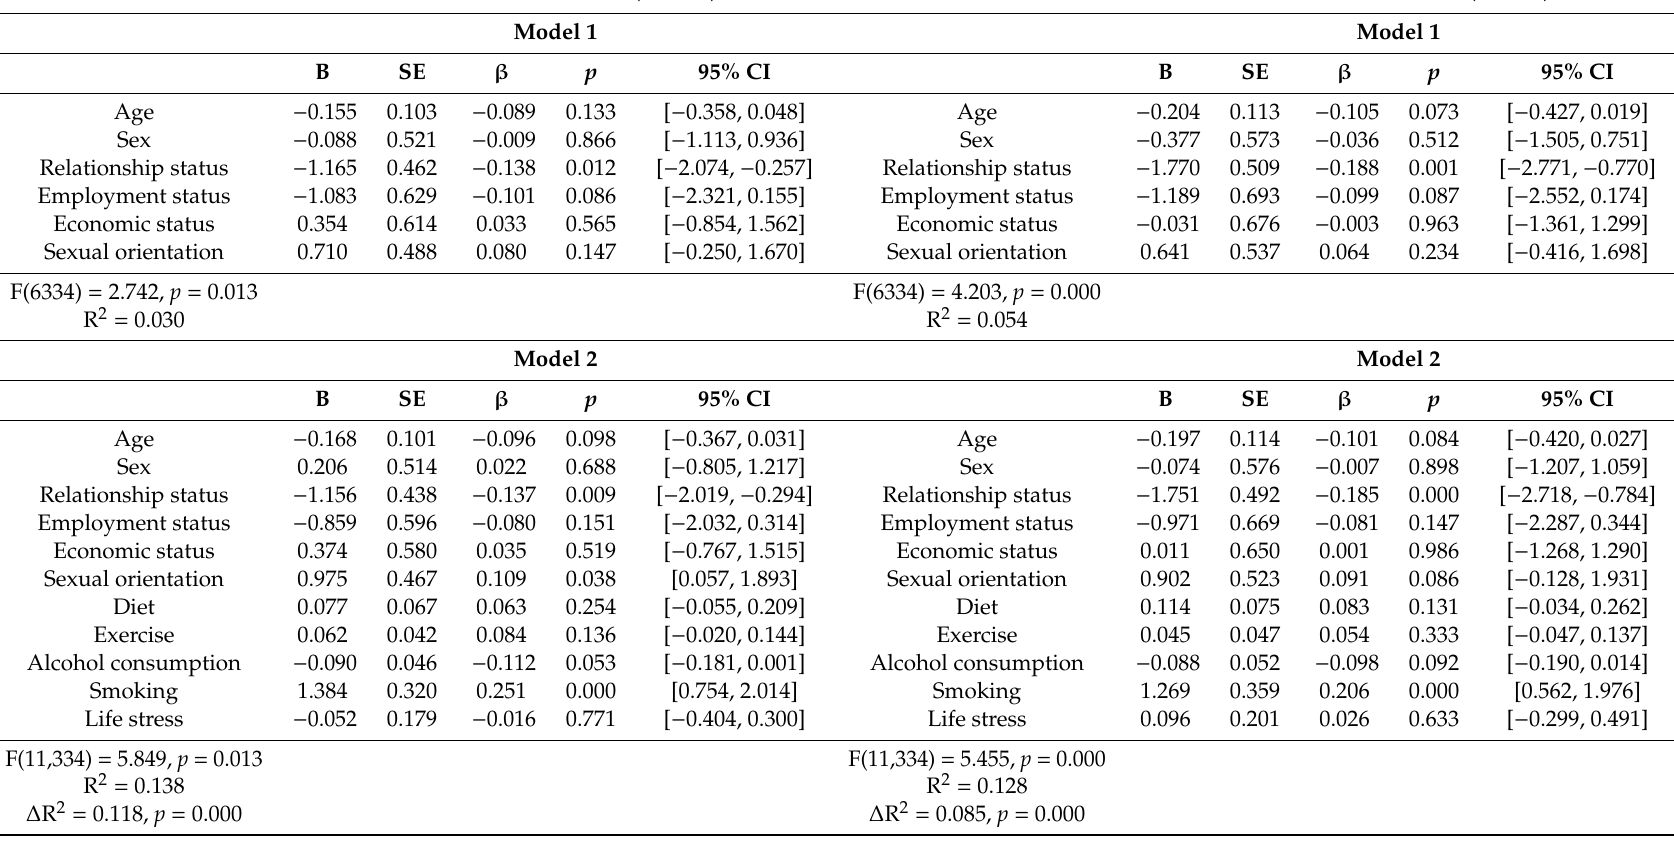
Table 6. Predictive value of personal and lifestyle variables on CUSEI and SAS-B dimensions of HIV risk factors.